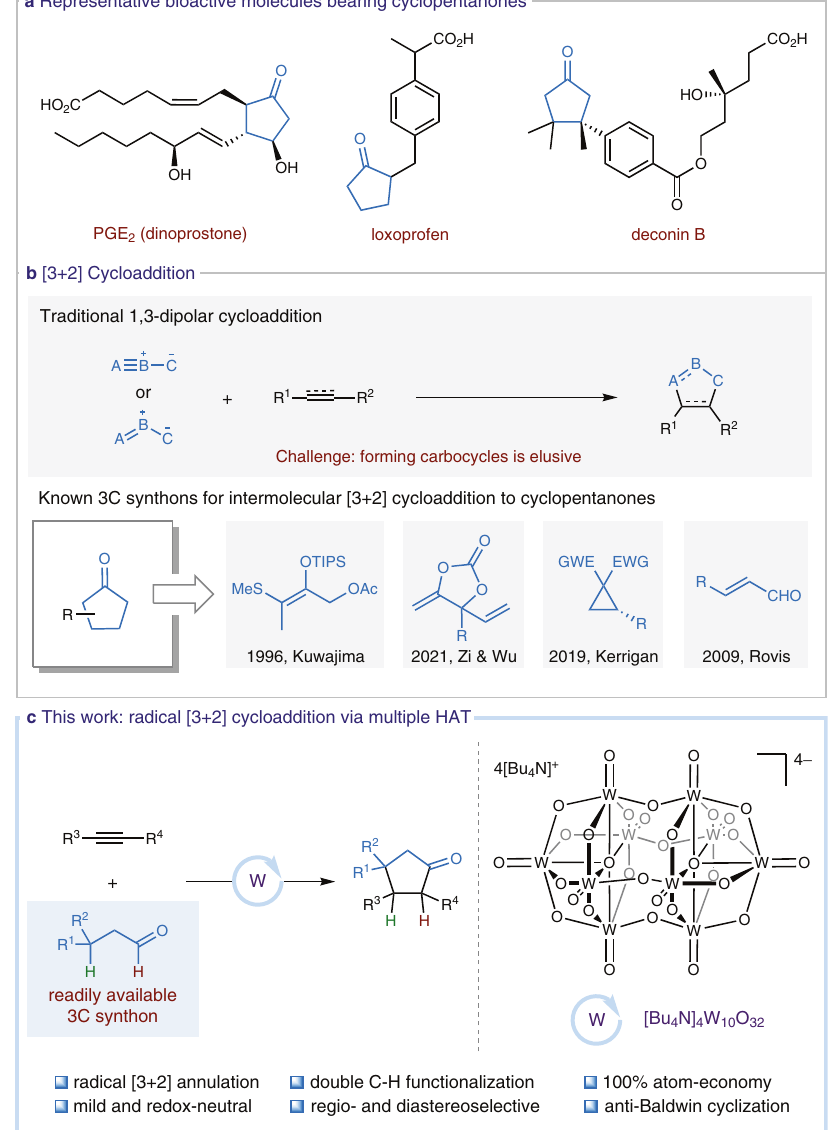
Fig. 1 | Background and summary of this work. 3C three carbon. TIPS triiso- propylsilyl. EWG electron-withdrawing group. W tetra- n -butylammonium dec- atungstate. a Representative bioactive molecules bearing